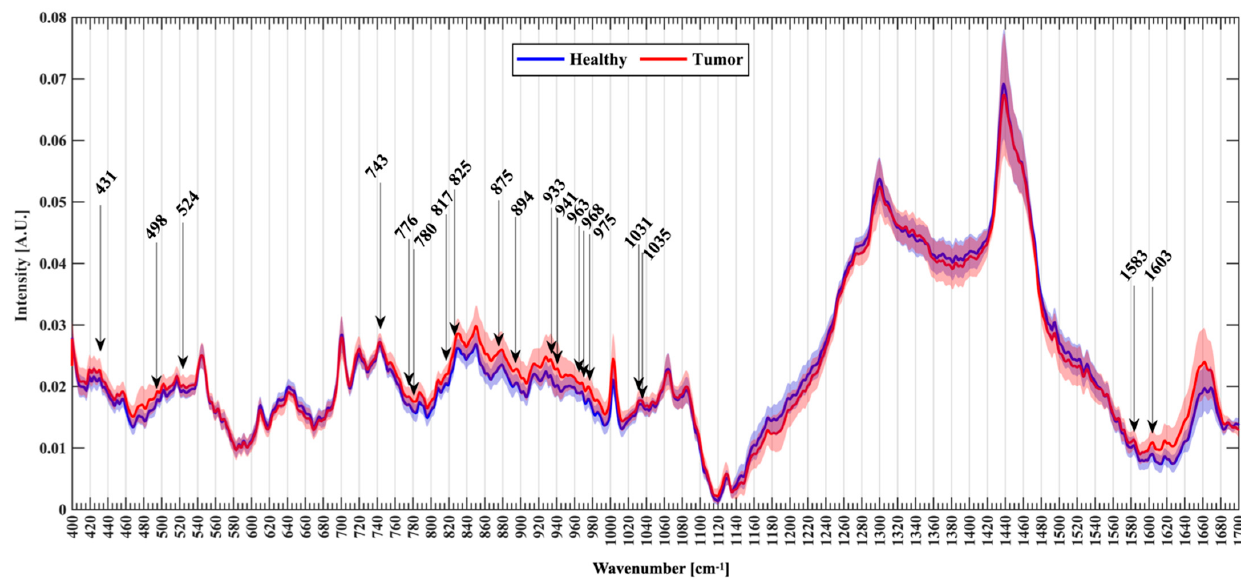
Figure 2. Normalized mean spectra with standard deviation for healthy (blu) and tumor patients (red). Arrows mark the new Raman peaks identified.